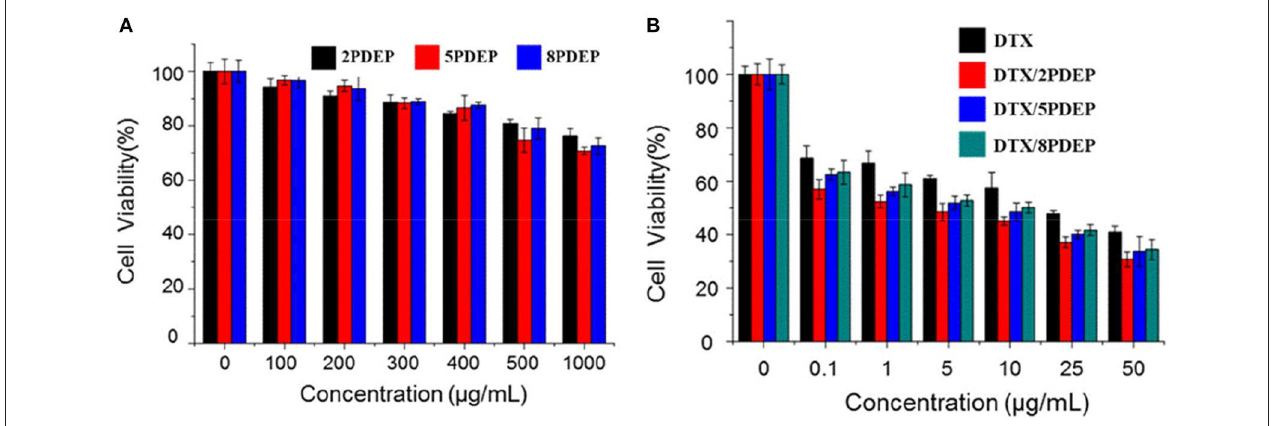
FIGURE 6 | Cytotoxicity of different drug forms for HepG2 cells. (A) Different PDEP micelle forms; (B) different DTX drug forms.